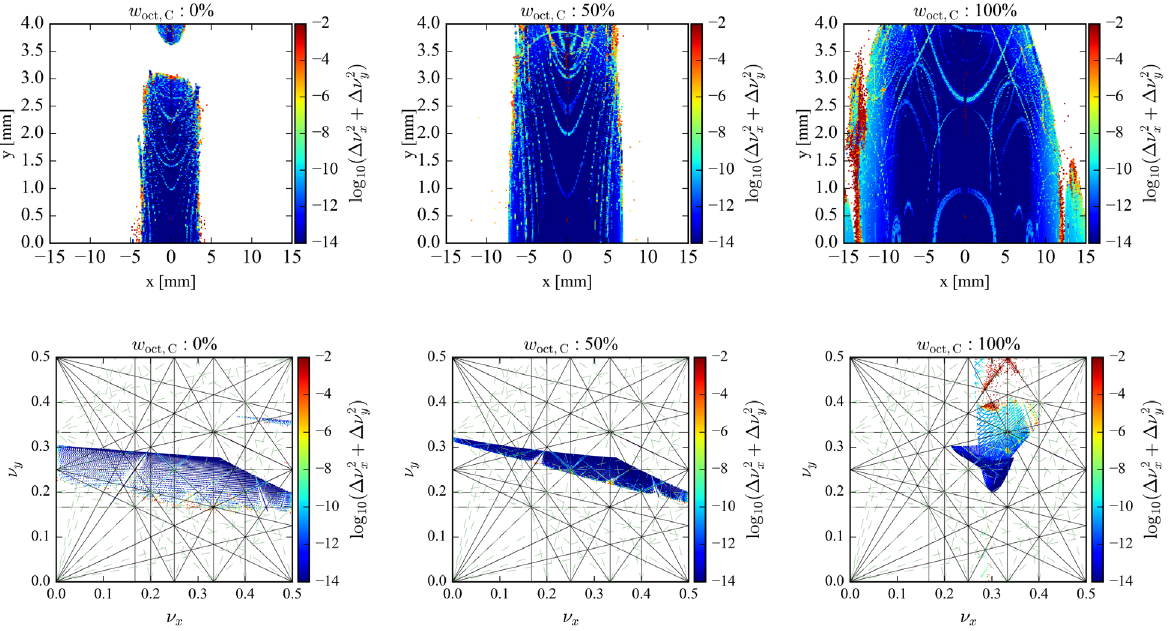
FIG. 8. On-momentum dynamic aperture increase with w , tracked at the injection point for 1024 turns. As the strength of the oct ; C optimal triplet oct increase, the tune footprint is confined into a smaller area in the tune space, making the particles less likely to cross C potentially harmful resonances during injection.